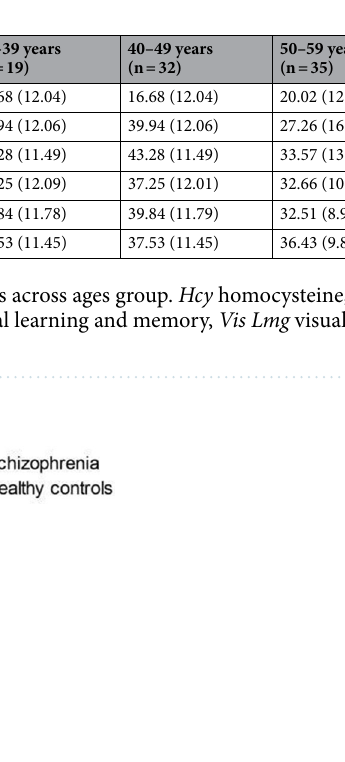
Figure 1. Differences in the plasma Hcy levels between patients with schizophrenia and healthy controls across age groups. *Significant differences in Hcy levels were observed between patients with schizophrenia and healthy controls ( p < 0.05). Hcy